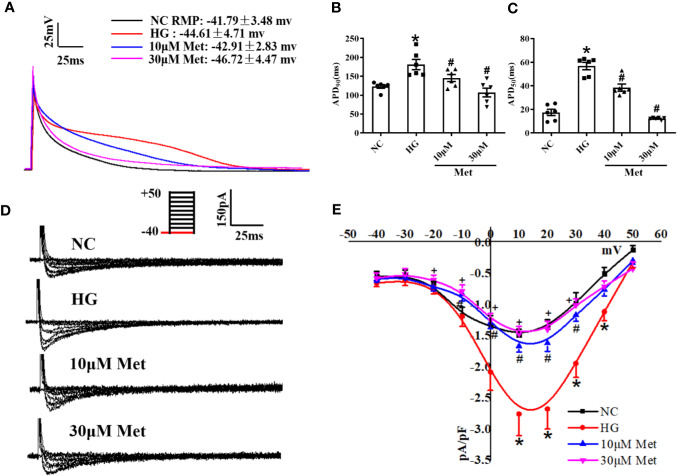
The effect of metformin on APD and ICa-L in high glucose cultured primary neonatal mice cardiomyocytes. (A) Representative action potential traces of primary cardiomyocytes in NC group, HG group and metformin-treatment group. (B) Relative levels of APD90 of primary cardiomyocytes in NC group, HG group and metformin-treatment group. (C) Relative levels of APD50 of primary cardiomyocytes in NC group, HG group and metformin-treatment group. (D) Representative ICa-L traces of primary cardiomyocytes in NC group, HG group and metformin-treatment group. The holding potential was -40mV. (E) I-V curves of ICa-L, of primary cardiomyocytes in NC group, HG group and metformin-treatment group. Values represent mean ± SEM, nNC = nHG = nMetformin = 6. *P < 0.05 versus NC, #P < 0.05 versus HG.